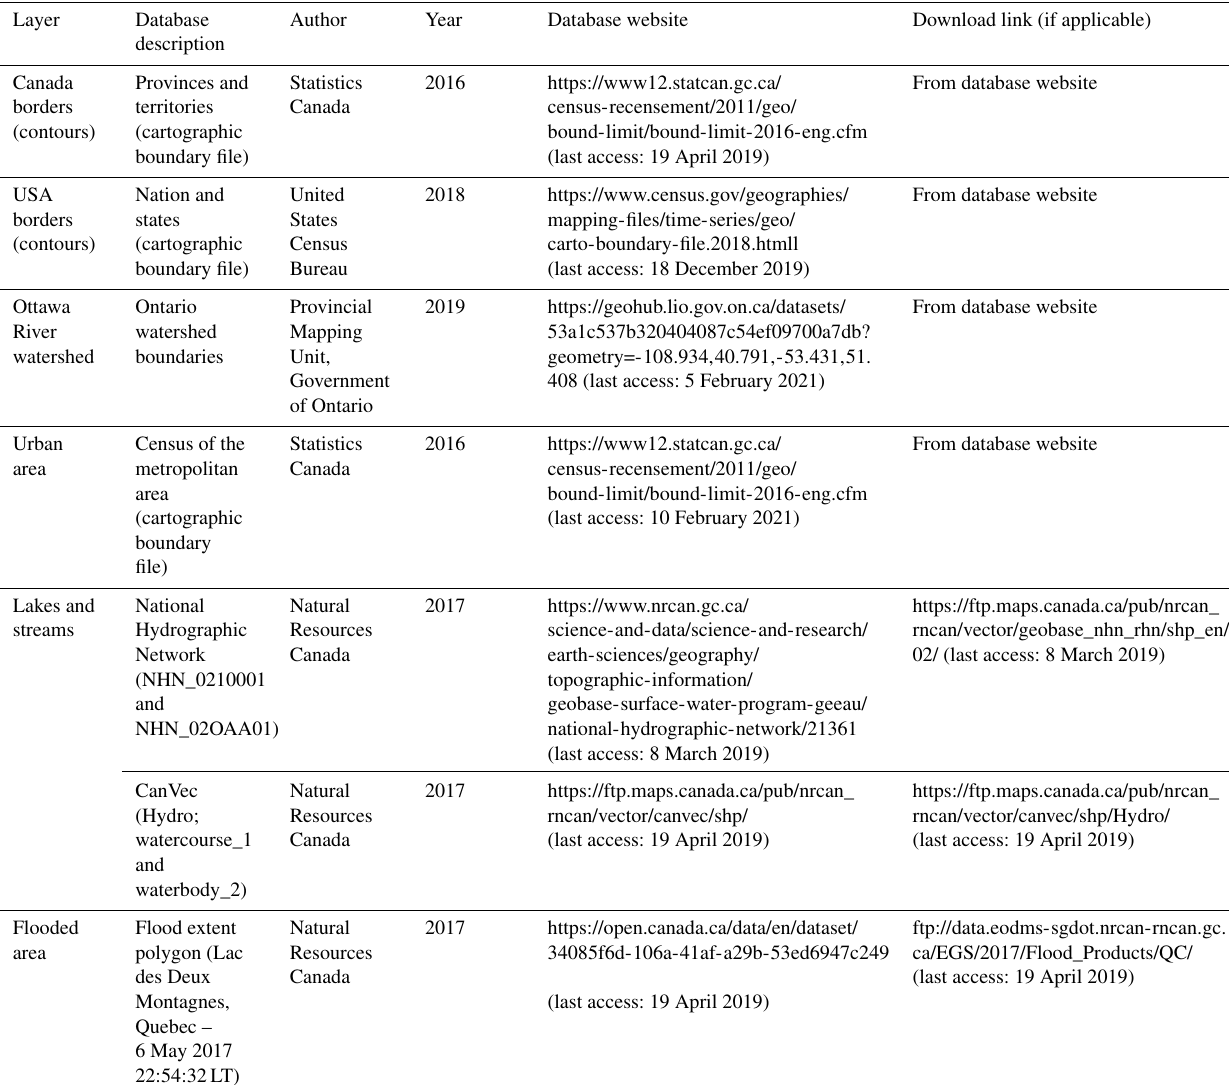
Table A1. Detailed source information and download links for the openly available geospatial data in Fig. 1. All data are openly available and are used in accordance with the Open Government Licence – Canada or the Open Data Policy, M-13-13, of the United States Census